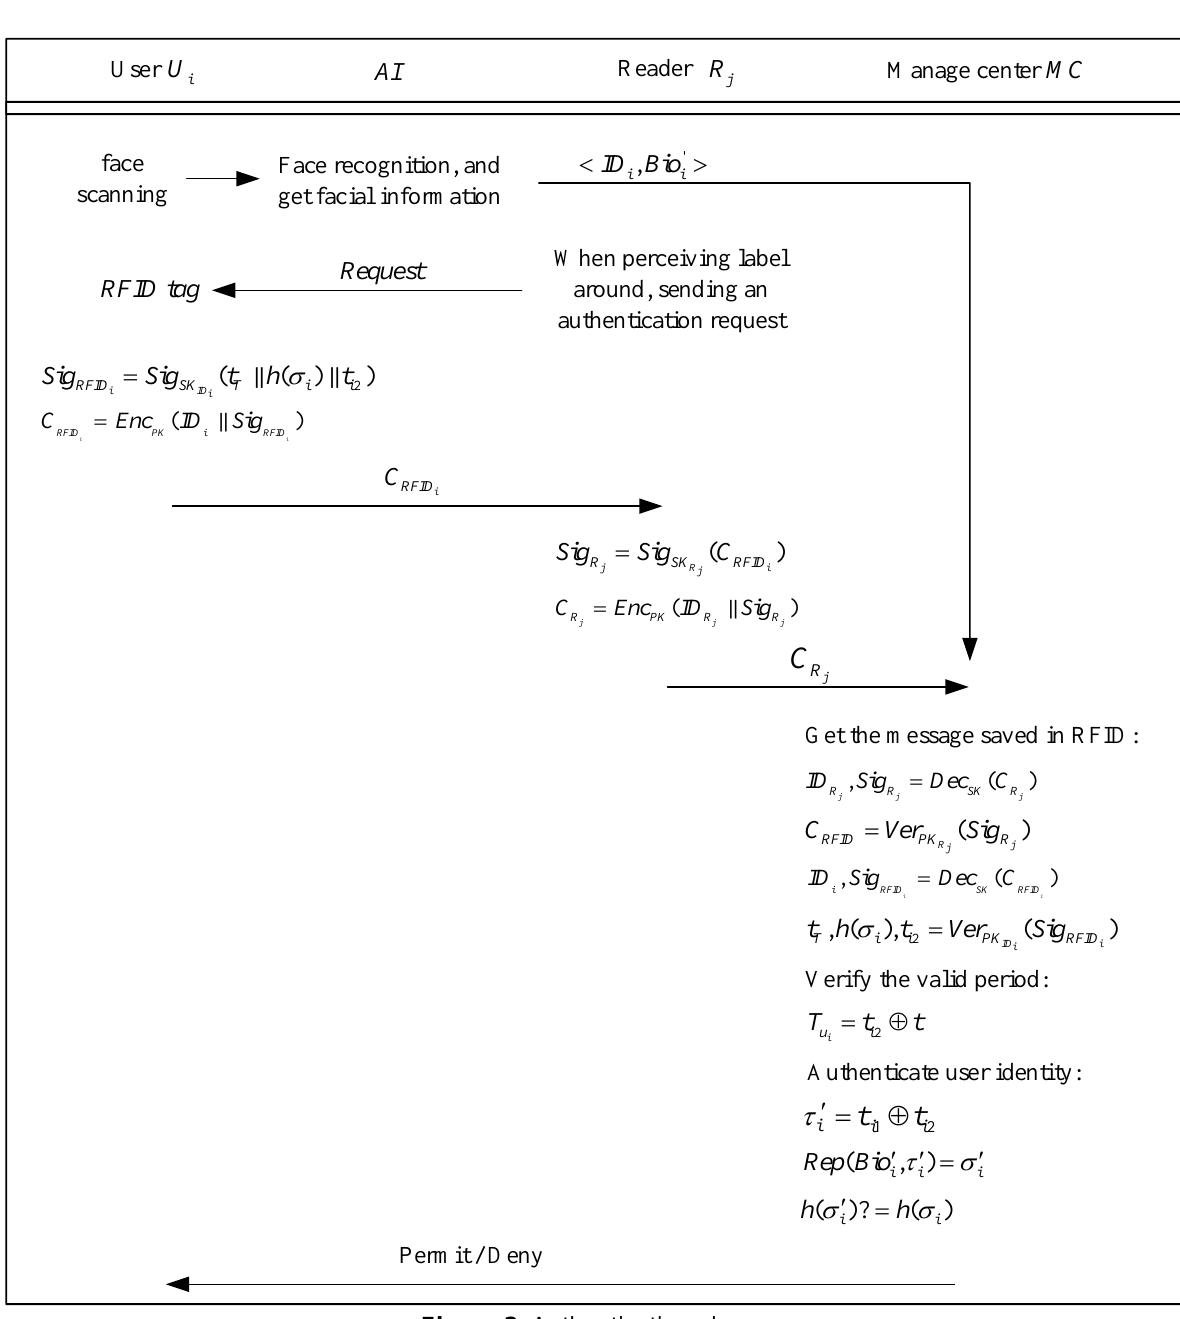
Figure 2 . Authentication